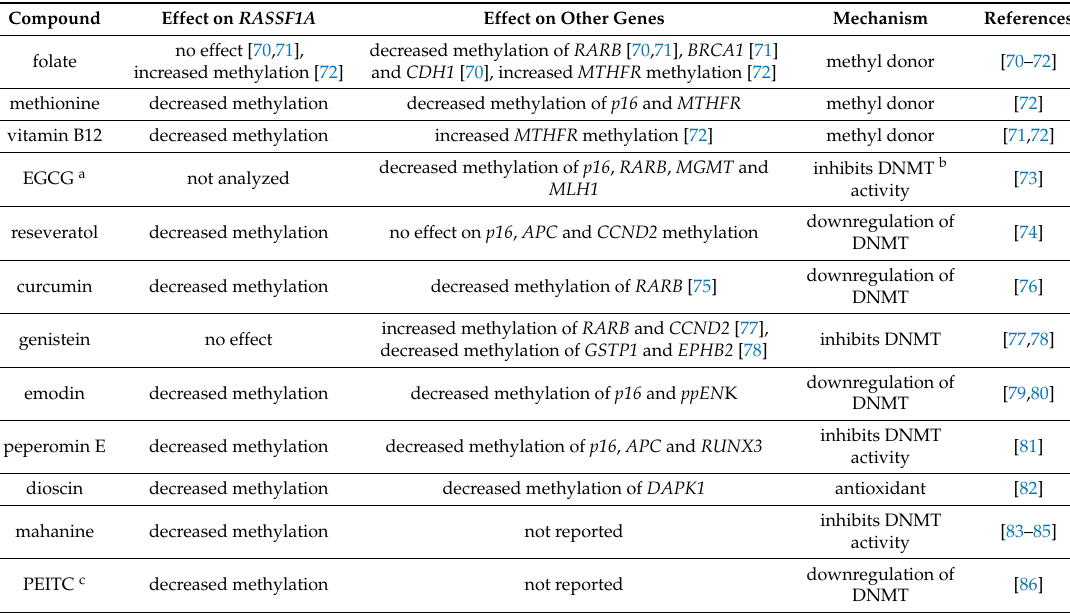
Table 1. Natural compounds tested for RASSF1A reactivation in